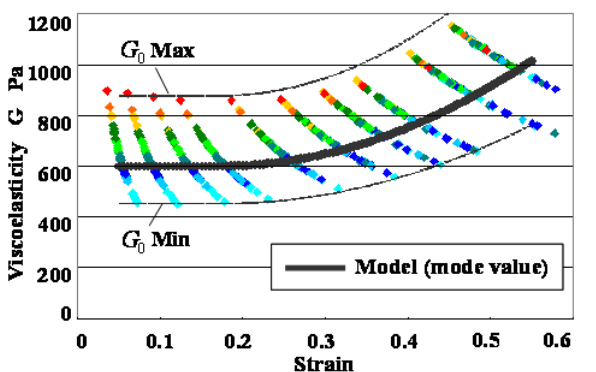
Fig.5 Variation in nonlinear properties. Each color of the plot indicates data from a specific hog liver. The experimental results show significant variations. For this reason, we have plotted two curves; one using the mode value of γ the other using the mode value of γ maximum value of G o , . Almost all of the plots are between the two curves. value of G o